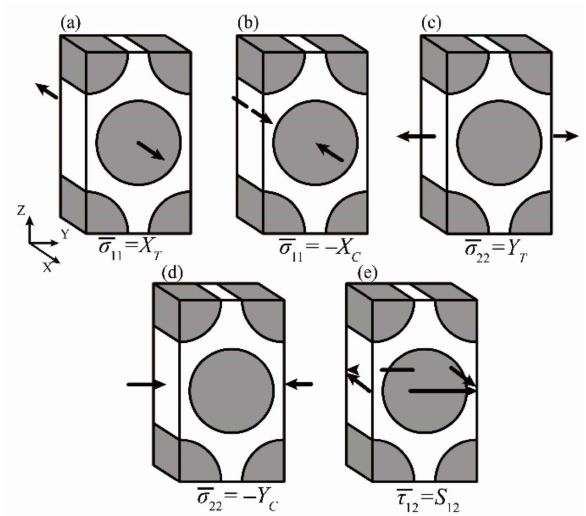
Figure 6. Micro-scale RUC under different loading conditions of macro-scale strengths: ( a ) RUC under X T ; ( b ) RUC under— X C ; ( c ) RUC under Y T ; ( d ) RUC under— Y C ; ( e ) RUC under S 12